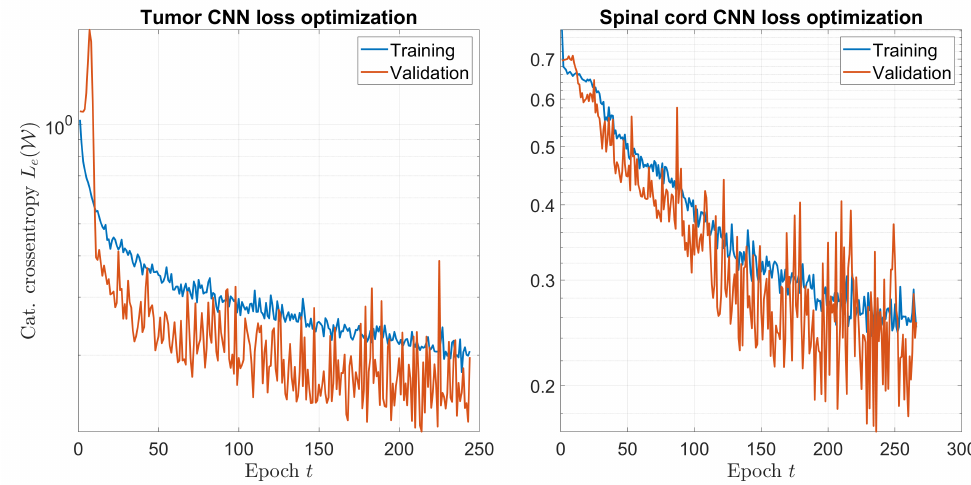
Figure 7. Categorical cross-entropy optimization of the considered CNNs versus the number of